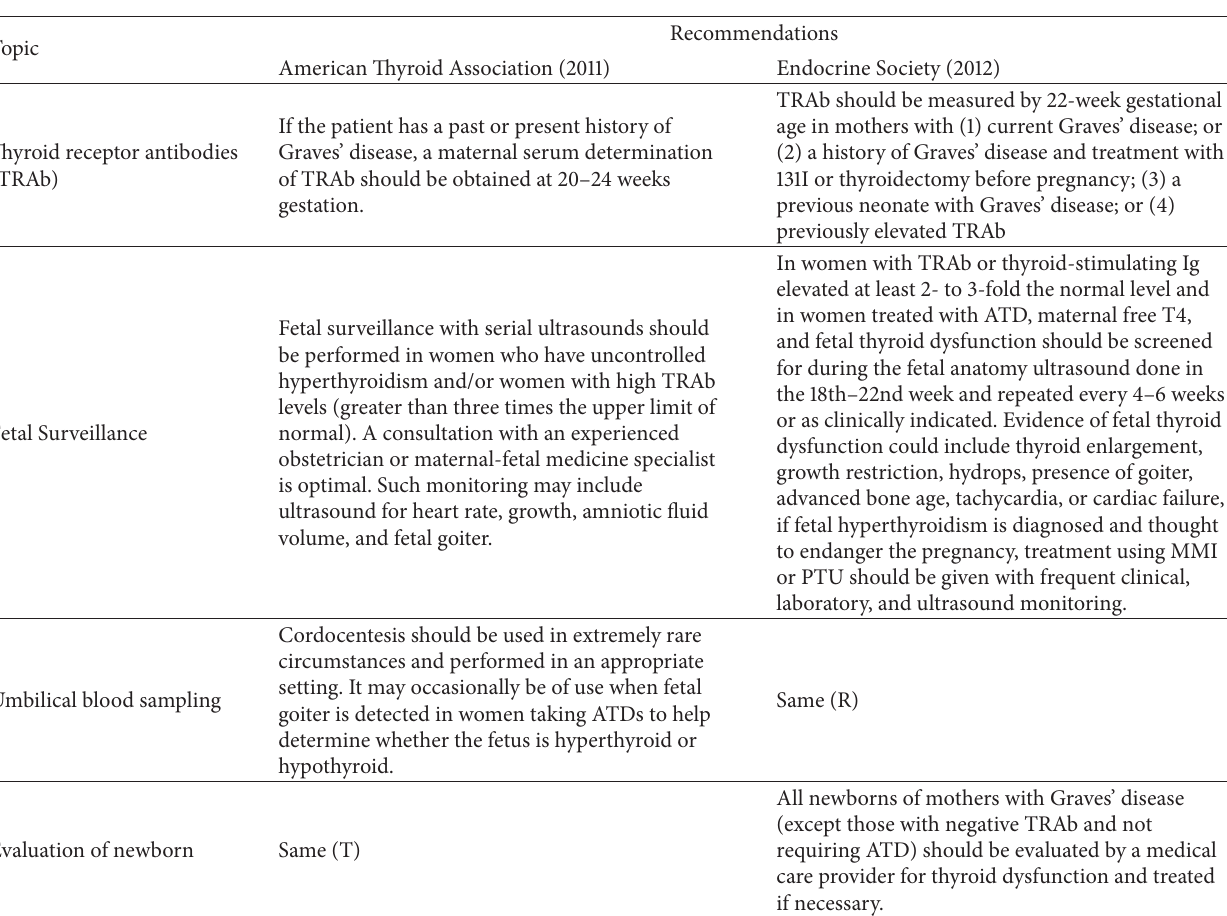
Table 3: Comparison of recommendations of American Thyroid Association and Endocrine Society on the fetal aspects of hyperthyroidism in pregnancy.